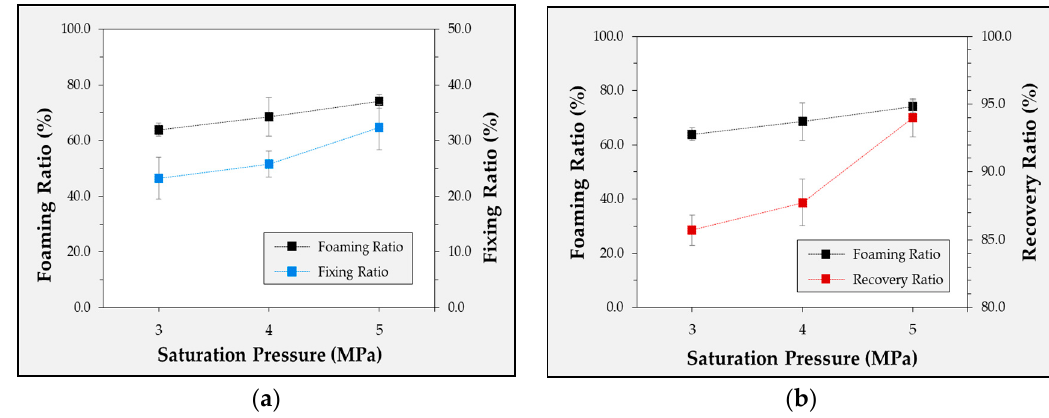
Figure 5. Experimental results for the correlation between the foaming ratio and the fixing ratio ( a ) and recovery ratio ( b ) according to the saturation pressure. Polymers 2020 , 12 , x FOR PEER REVIEW Table 7. Foaming properties of thermoplastic polyurethanes (TPU) according to saturation pressure.